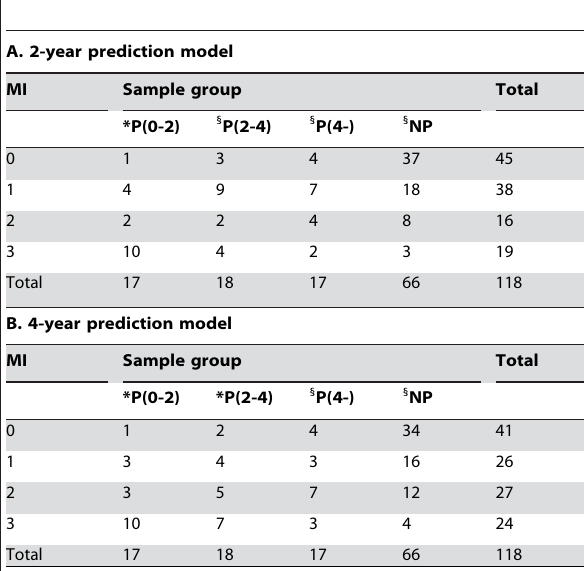
Table 2. Methylation Index (MI) and Barrett’s